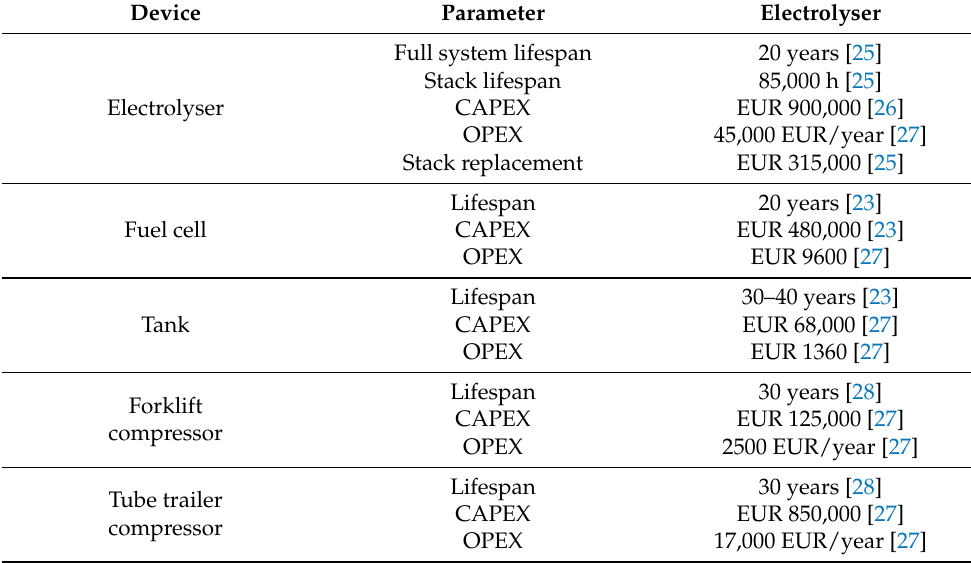
Table 3. Economic characteristics of the H 2 PP equipment.